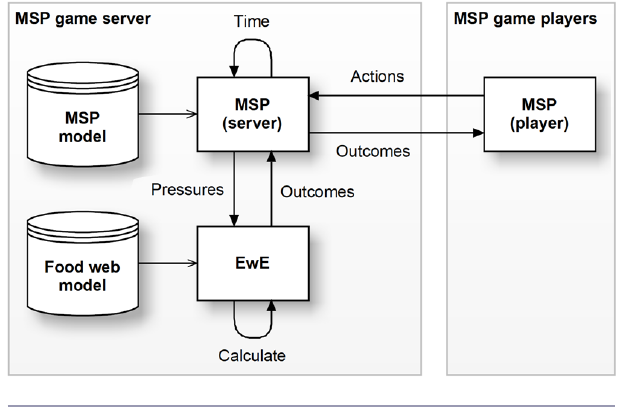
Fig. 1. Conceptual linkage of the marine spatial planning (MSP) and Ecopath with Ecosim (EwE) platforms. While game time progresses, players’ plans (actions) translate into changes in environment and policy (pressures), which are included in the food web calculations of EwE. Ecological estimates are summarized (outcomes) and sent back to game